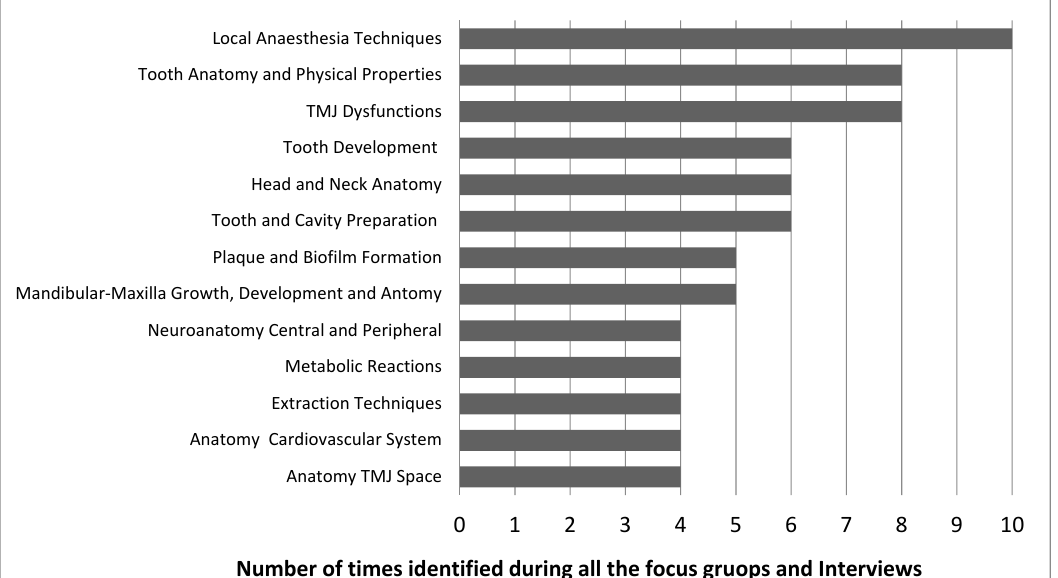
Figure 2. Most recurrent Items from all the focus group sessions and interviews.